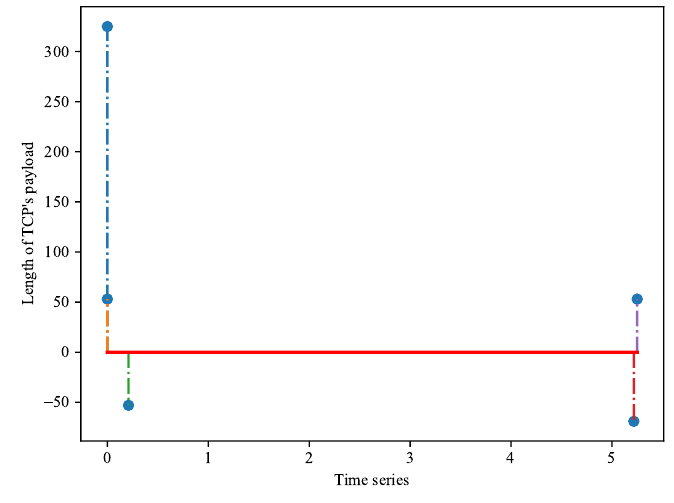
Figure 4. APNs traffic